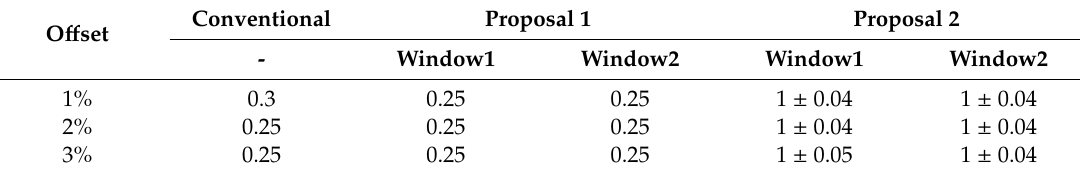
Table 7. Optimum thresholds of